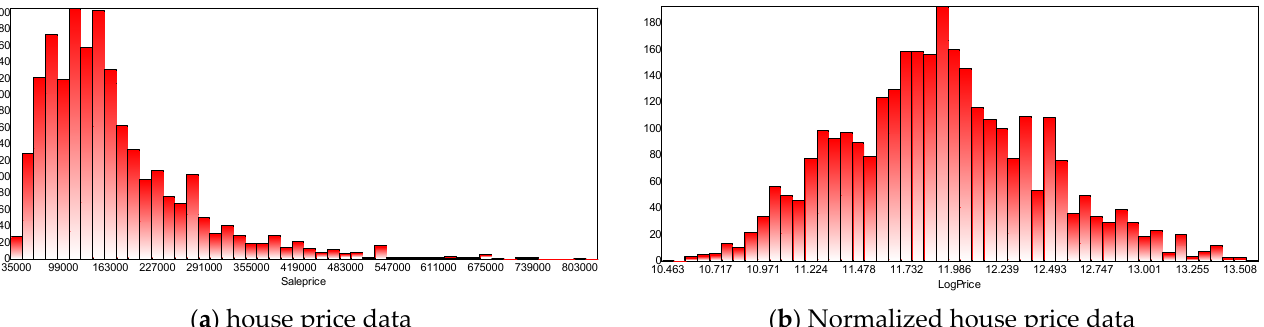
Figure 2. Distribution of sales price across the Belfast Housing Market Area in 2021.